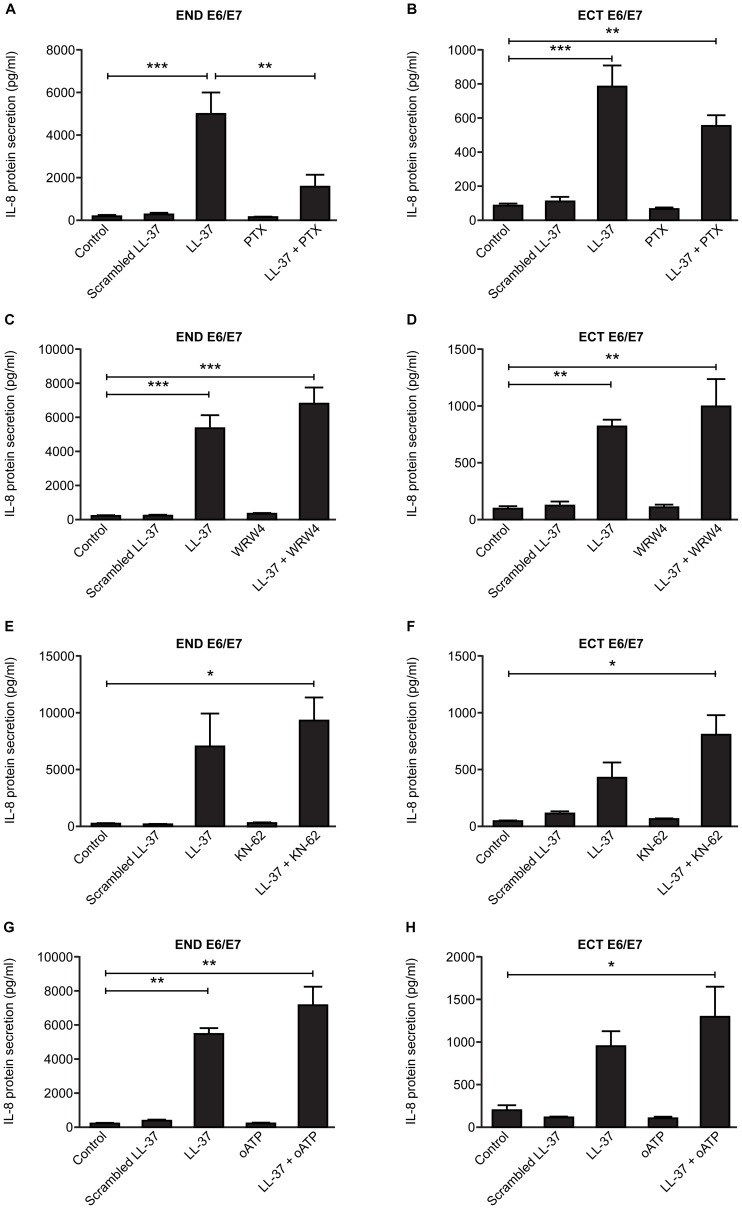
Effect of LL-37 receptor antagonists on IL-8 secretion in endocervical (END E6/E7) and ectocervical (ECT E6/E7) cell lines.END E6/E7 cells were pre-treated for 30 minutes with or without antagonists before being cultured for 24 hours with scrambled LL-37 (25 µg/ml) and LL-37 (25 µg/ml). (A) END E6/E7 treated with PTX (GPCR antagonist, 200 ng/ml), (B) ECT E6/E7 cells treated with PTC, (C) END E6/E7 cells treated with WRW4 (FPR2 antagonist, 10 µM), (D) ECT E6/E7 cells treated with WRW4, (E) END E6/E7 cells treated with KN-62 (P2X7R antagonist, 10 µM), (F) ECT E6/E7 cells treated with KN-62, (G) END E6/E7 cells treated with oATP (P2X7R antagonist, 100 µM) and (H) ECT E6/E7 cells treated with oATP. Data presented as mean concentration ± SEM (error bars). *, **, ***, p<0.05, 0.01, 0.001 respectively. (2way ANOVA with multiple comparison tests).